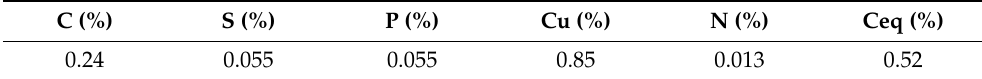
Table 1. Chemical composition of B500c